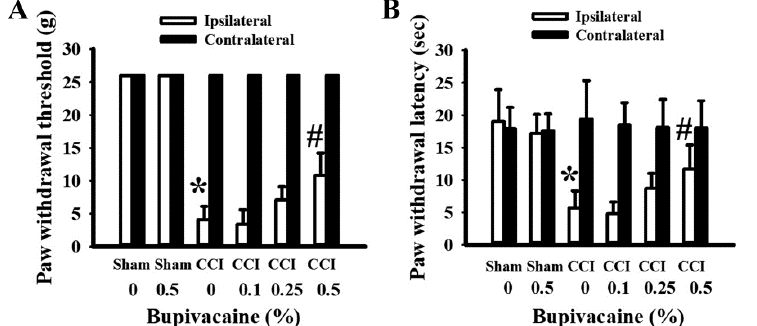
Figure 1. Bupivacaine alleviated mechanical allodynia and thermal hyperalgesia in CCI rats. Rats were intrathecally injected with the indicated concentrations of bupivacaine (0–0.5%, diluted in saline) for 30 min prior to being subjected to sham and CCI operation. Seven days later, mechanical allodynia ( A ) and thermal hyperalgesia ( B ) were evaluated in the ipsilateral and contralateral limbs. * p < 0.05 vs. sham/saline/ipsilateral group and # p < 0.05 vs. CCI/saline/ipsilateral group, n = 6.